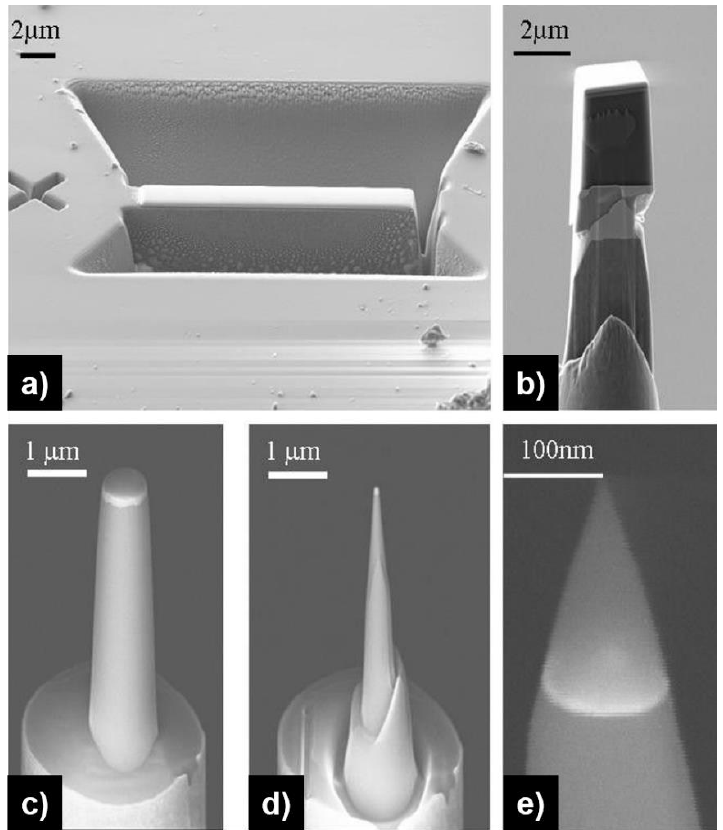
Figure 2. Procedure for Atom Probe Tomography (APT) specimen preparation by focused ion beam (FIB)-SEM: ( a ) lift-out method used to extract the lift-out bar made of the material of interest; ( b ) transfer of a portion of the bar onto a micro-post; ( c – e ) successive annular milling of decreasing size allow to obtain a sharp tip with a radius of curvature below 50 nm. Reprinted from [77] under the terms of the Creative Commons Attribution License.